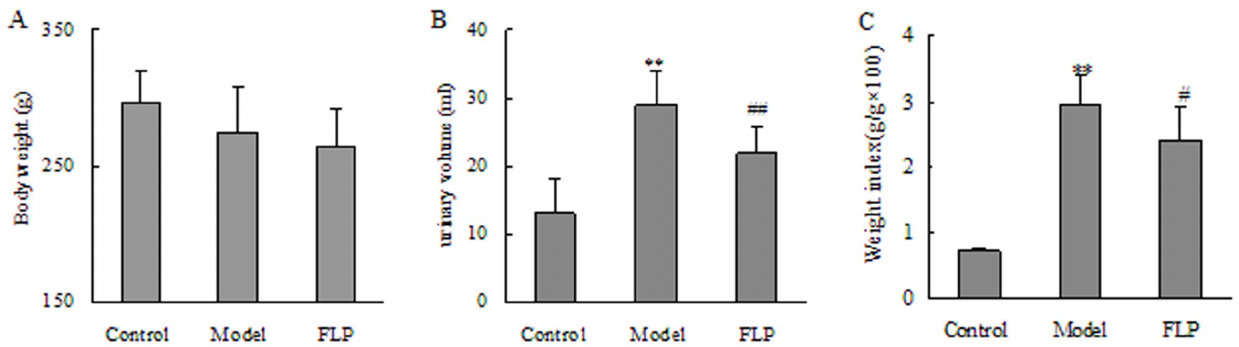
Figure 1. Physical parameter comparisons among the studied groups. (A) Body weight; (B) urinary volume and (C) kidney weight index. The data were expressed as mean 6 SD. * P , 0.05, ** P , 0.01 compared to the control groups and # P , 0.05, ## P , 0.01 compared to the CKD groups.